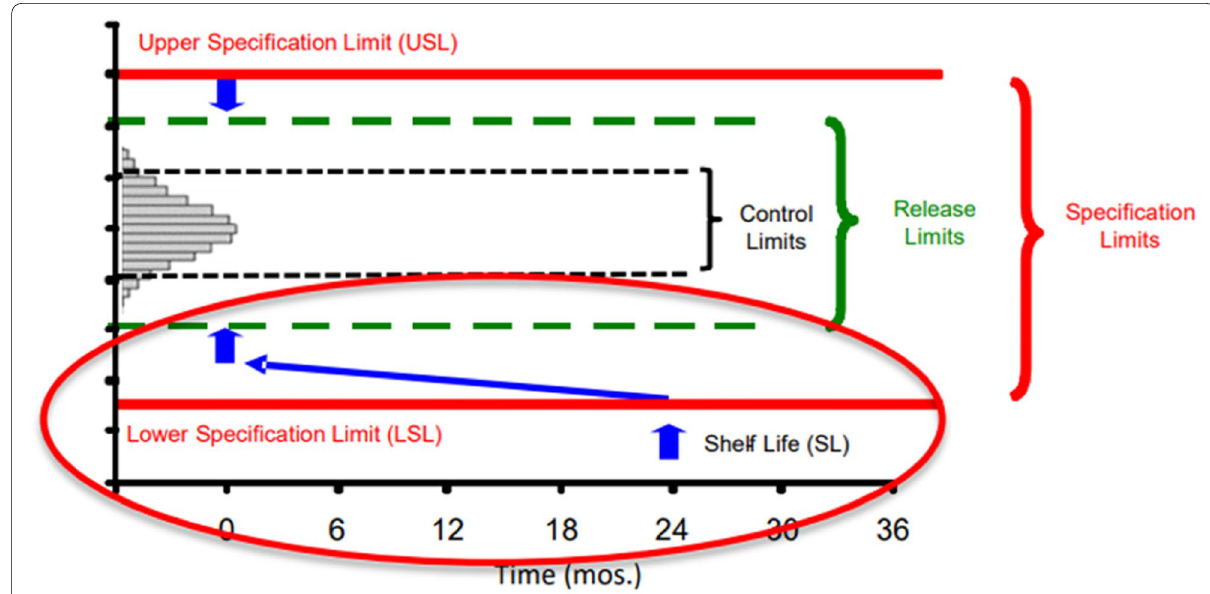
Fig. 3 Vaccine Analytical Control Strategy. Excerpt from Schofield, T., Principles and Practices of Vaccine Stability Modeling. AAPS Vaccine